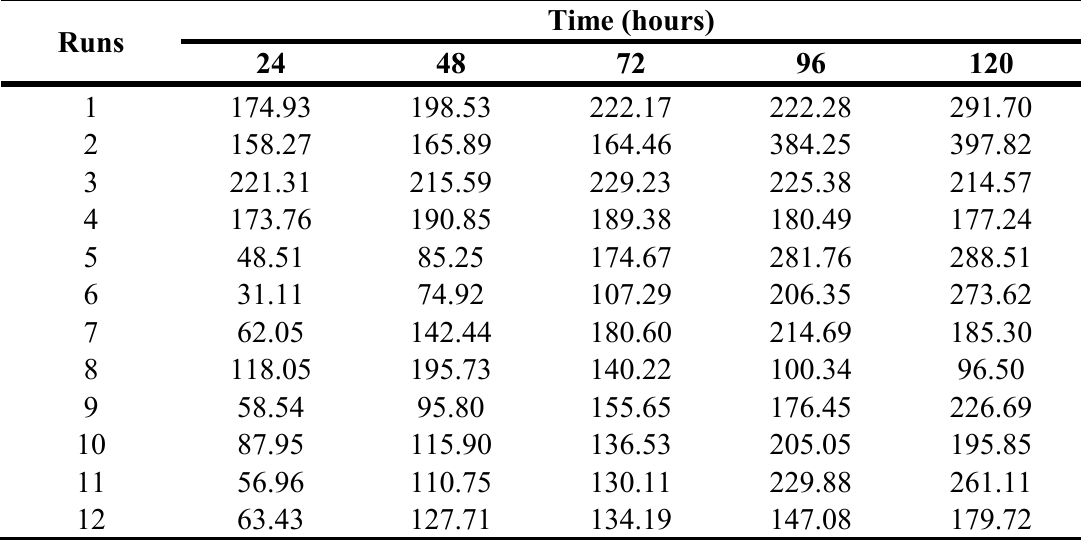
Table 2. Xylanase activity (U/g) in SSF during 120 hours of fermentation by Lichtheimia blakesleeana URM5604 using citrus pulp as substrate.